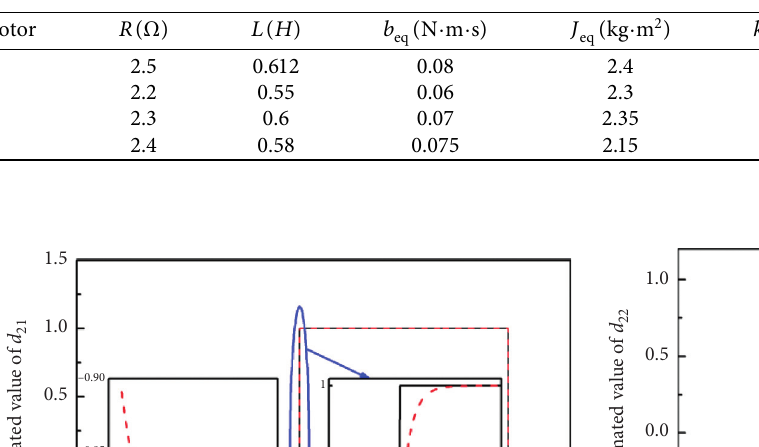
Table 1: Motor parameter settings.